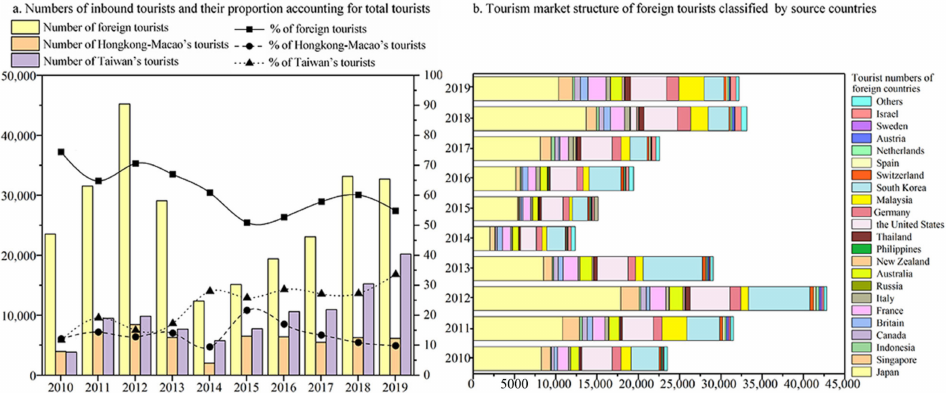
Figure 5. Tourism market structure of numbers and proportions of inbound tourists,